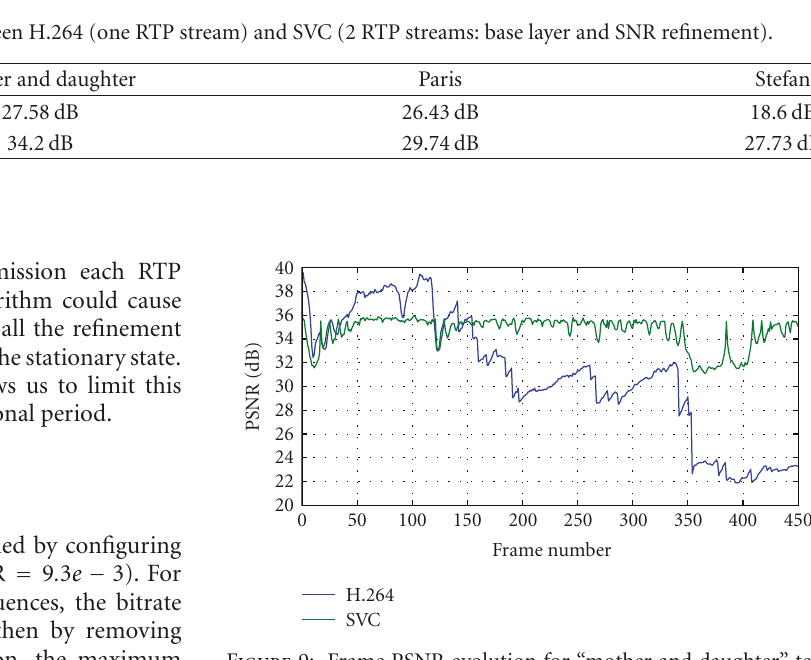
Figure 9: Frame PSNR evolution for “mother and daughter” test sequence (BLER = 3 . 3%, tti = 10